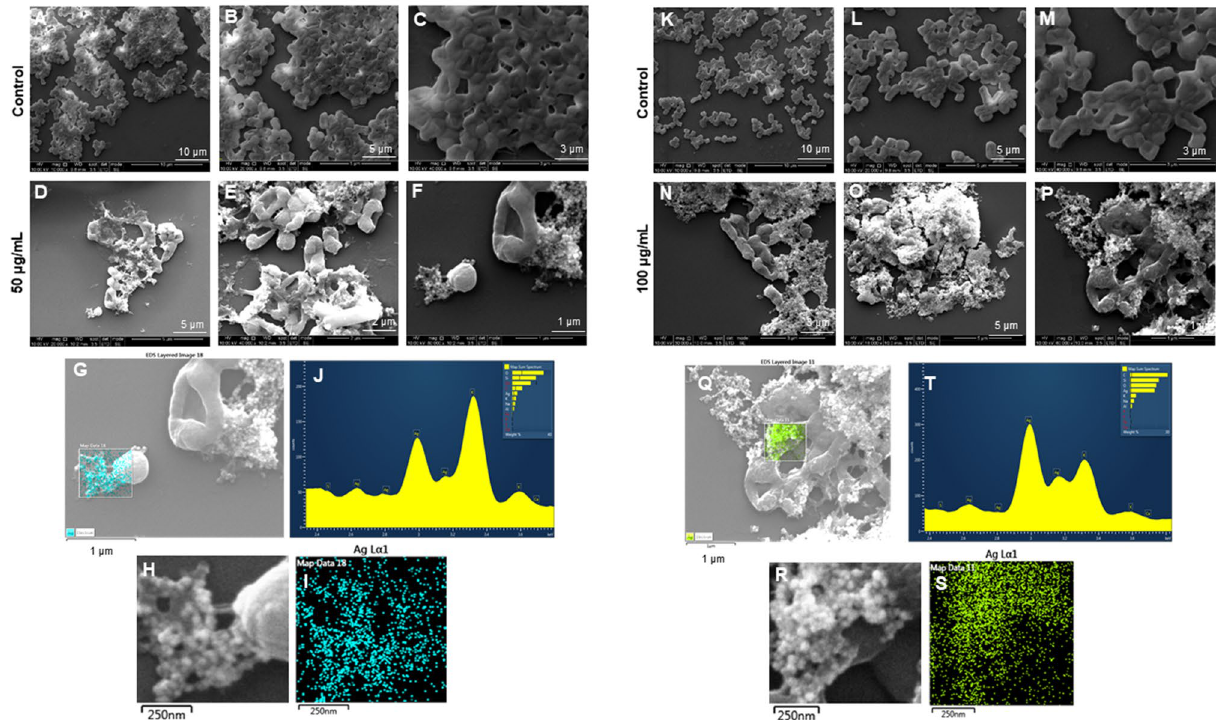
Figure 11. SEM analysis of E. coli cells after treatment with LV-AgNPs. (A-F) Control cells and LV-AgNPs treated cells with 50 μg/ml at different scales. (G) Scanned image of treated cells (H,I) elemental mapping of the selected area showing silver element in the treated cells, (J) EDX spectrum of the chosen area showing peak for silver element. (K-P) Control cells and LV-AgNPs treated cells with 100 μg/ml at different scales. (Q) Scanned image of treated cells (R,S) elemental mapping of the selected area showing silver element in the treated cells, (T) EDX spectrum of the chosen area showing peak for silver